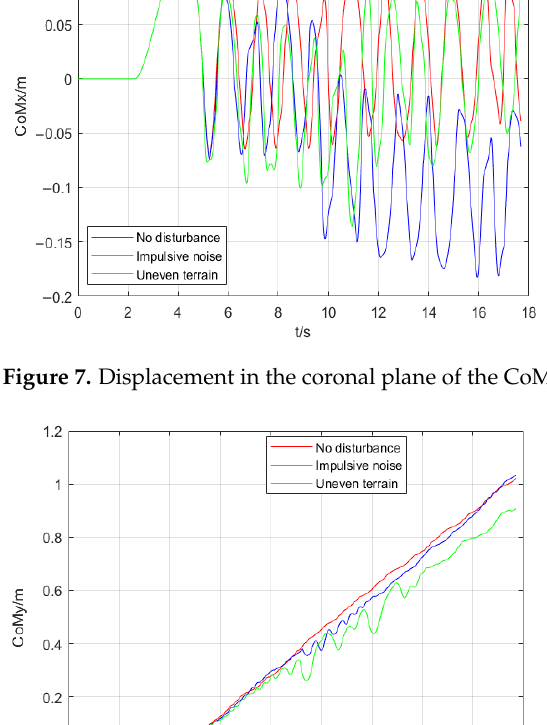
Figure 7. Displacement in the coronal plane of the CoM.